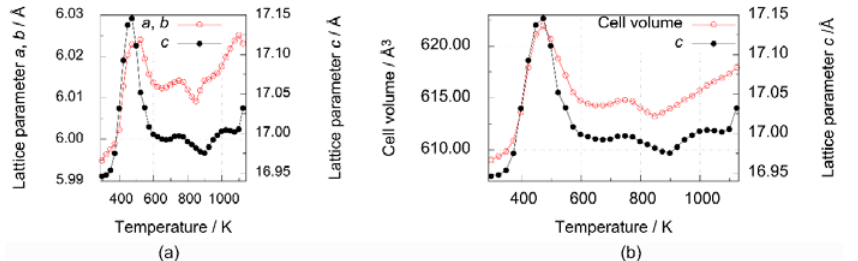
Figure 10. ( a ) Lattice parameters a,b , and c of Ba 2 In 1.8 Cr 0.2 O 5.3 (H 2 O) x (batch 1) while heating under nitrogen flow of 20 sccm ( p = 0.15 MPa, p (O 2 ) < 5 ppm, p (H 2 O) < 5 ppm) in an XRK reaction chamber mounted on a SmartLab X-ray diffractometer; ( b ) cell volume and lattice parameter c (batch 1) while heating under nitrogen flow of 20 sccm ( p = 0.15 MPa, p (O 2 ) < 5 ppm, p (H 2 O) < 5 ppm) in an XRK reaction chamber mounted on a SmartLab X-ray diffractometer; the lattice parameters and cell volume determined by Rietveld refinements, ± σ within dot size.